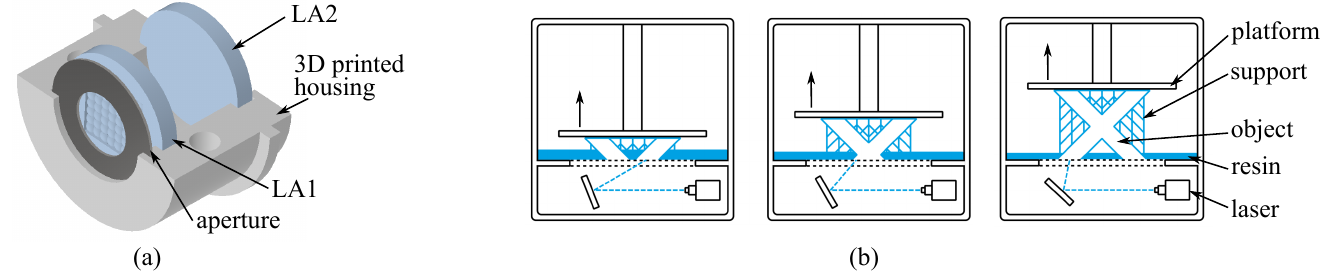
Figure 6. ( a ) Designed housing (lower part) for beam homogenization with the assembled lens arrays and aperture and ( b ) schematic of the additive manufacturing process using stereolithography for building the designed object layer by layer out of photosensitive resin.